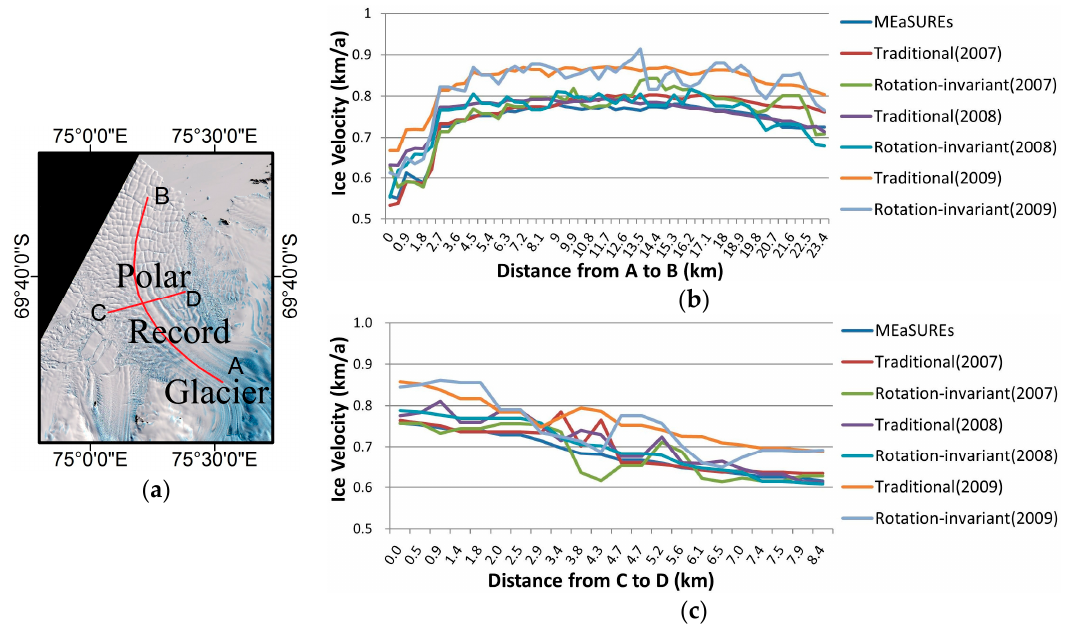
Figure 8. Ice velocity comparison between the traditional NCC-based feature-tracking method, the rotation-invariant feature-tracking method, and the velocities from the MEaSUREs InSAR-based Antarctic ice velocity map. ( a ) The location of the profiles from A to B and from C to D; ( b ) The different ice velocities from A to B; ( c ) The different ice velocities from C to D. Table 2. The accuracies of the different methods compared with the MEaSUREs InSAR-based Antarctic ice velocity map (m/a) (Profile from A to B).